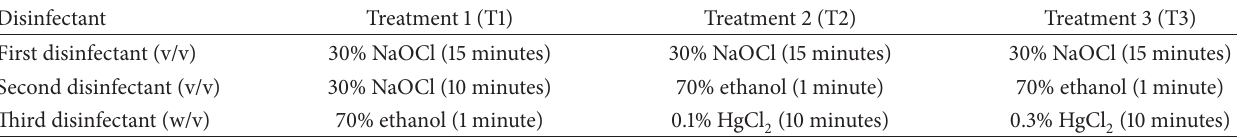
Table 1: Three different treatments in surface sterilization for shoot bud explants of C. crotalifera .